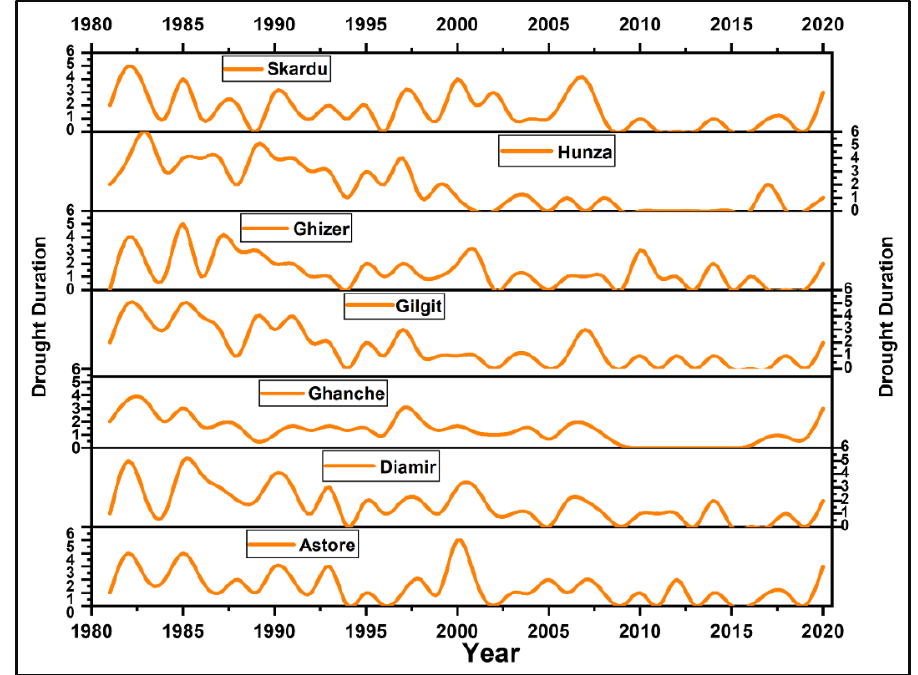
Figure 4. Drought duration for all districts.